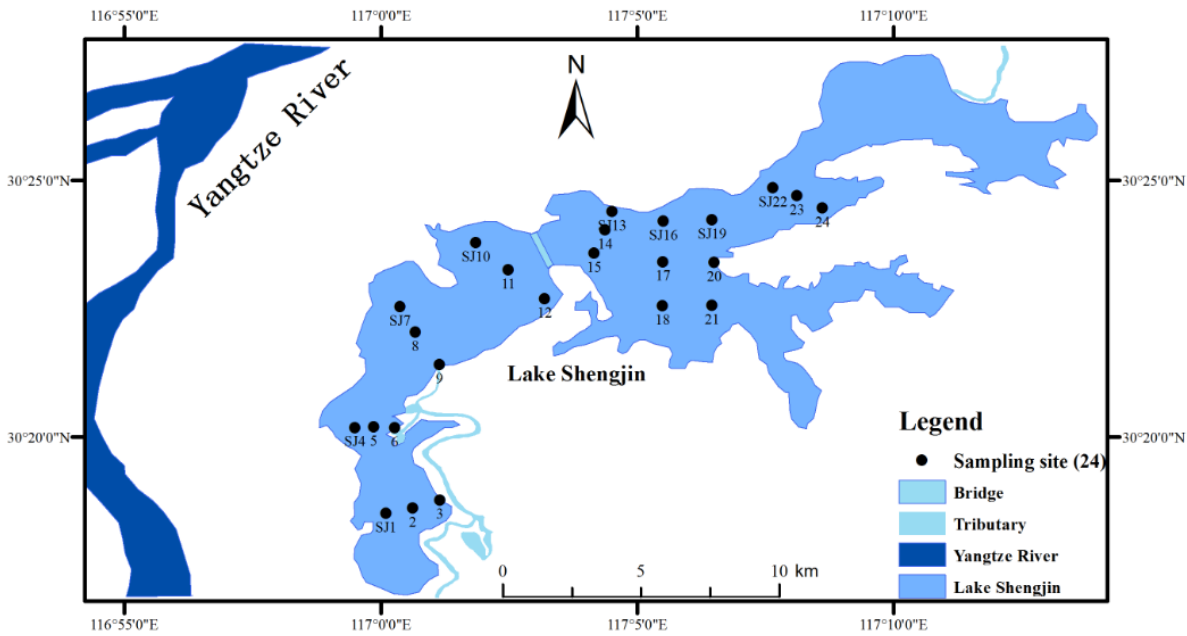
Figure 1. Distribution of sampling points in the study area of Shengjin Lake.